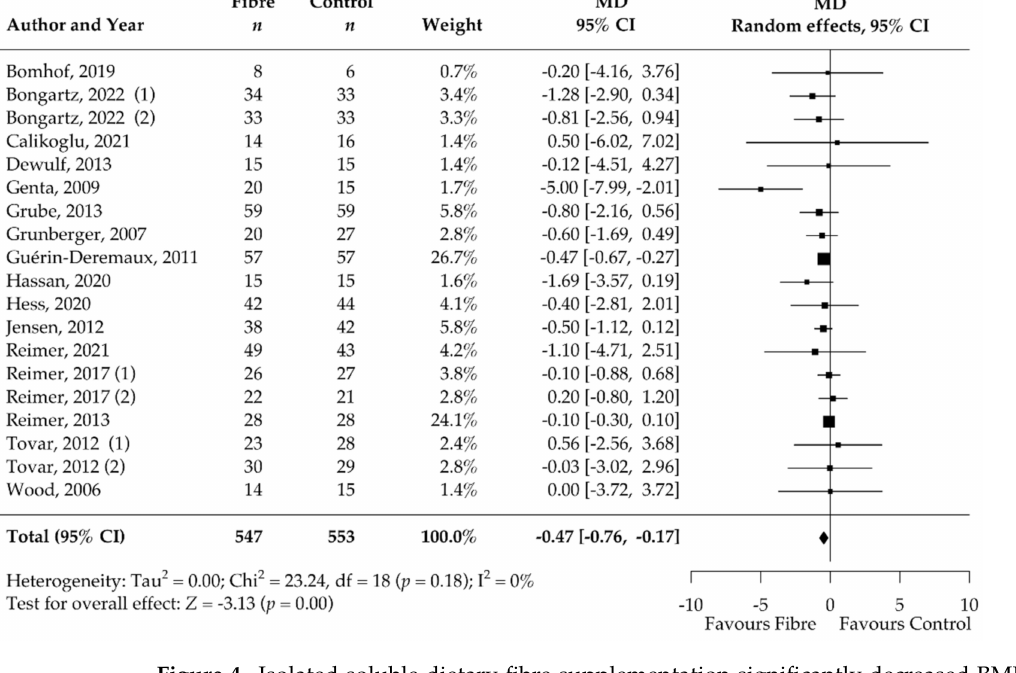
Figure 4. Isolated soluble dietary fibre supplementation significantly decreased BMI [kg/m 2 ] in overweight and obese people ( n = 1067). Black rectangles represent MD for each study; the size of the rectangle is proportional to the weight of the study for the pooled effect. Horizontal lines indicate 95% CI. The black diamond summarises the pooled MD data. MD = mean difference; (1)/(2) indicate cohort 1 and 2 of study [52–64,70–76].